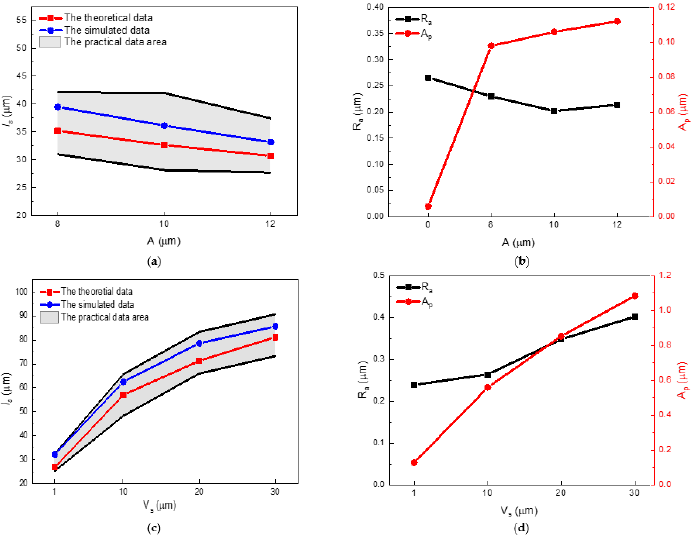
Figure 9. Micro-texture comparisons of groups 1 and 2: ( a ) A − R a − A p of group 1, ( b ) A − l s of group 1, ( c ) V s − R a − A p of group 2, and ( d ) V s − l s of group 2.